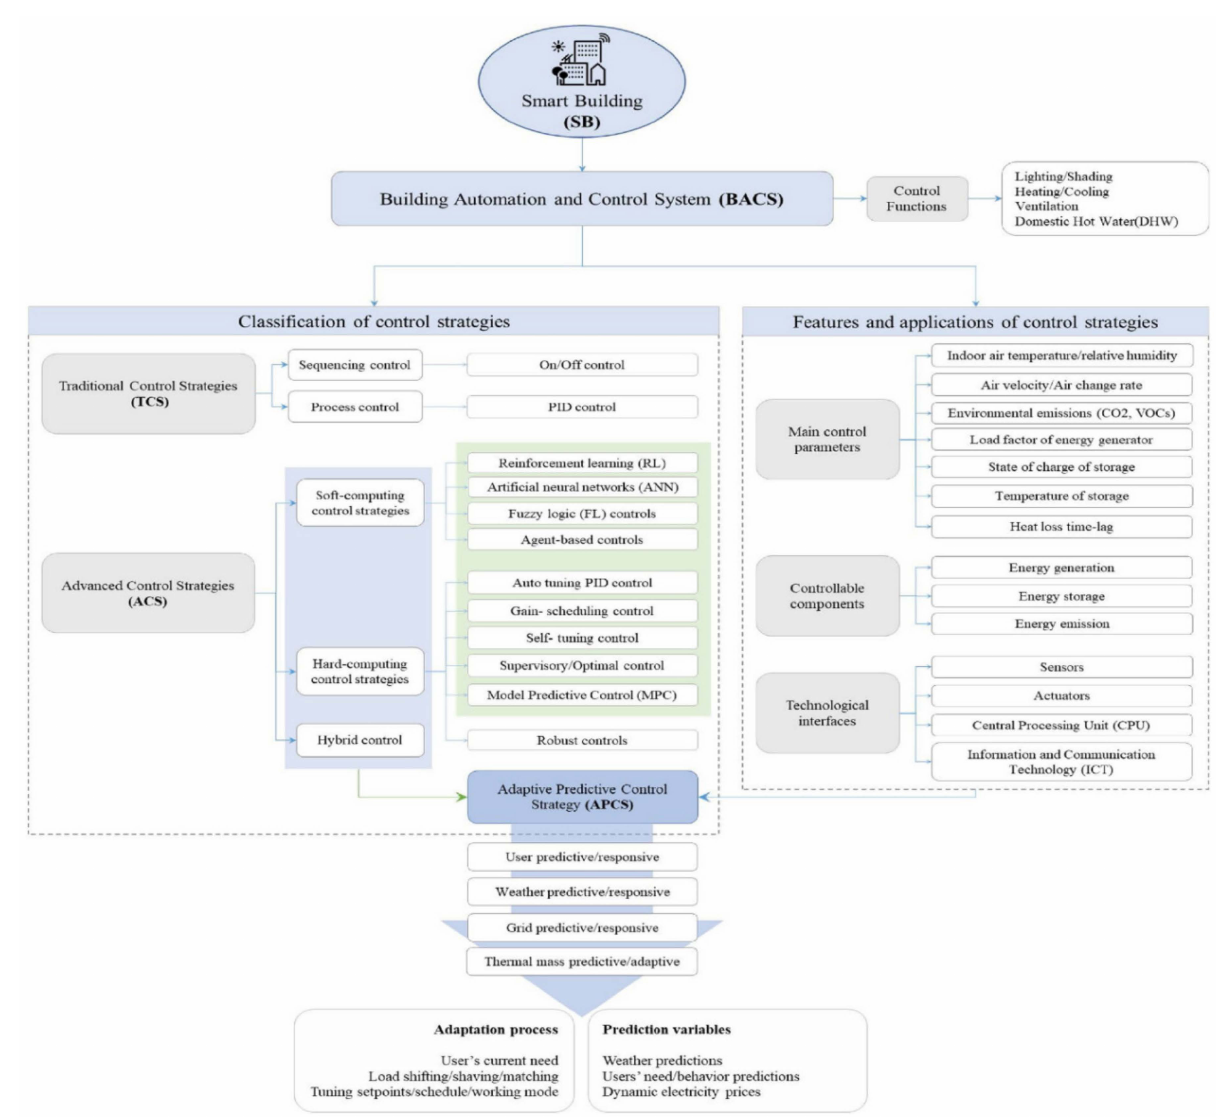
Figure 2. Features, applications, and functions of building automation and control system (BACS) in buildings and HVAC systems